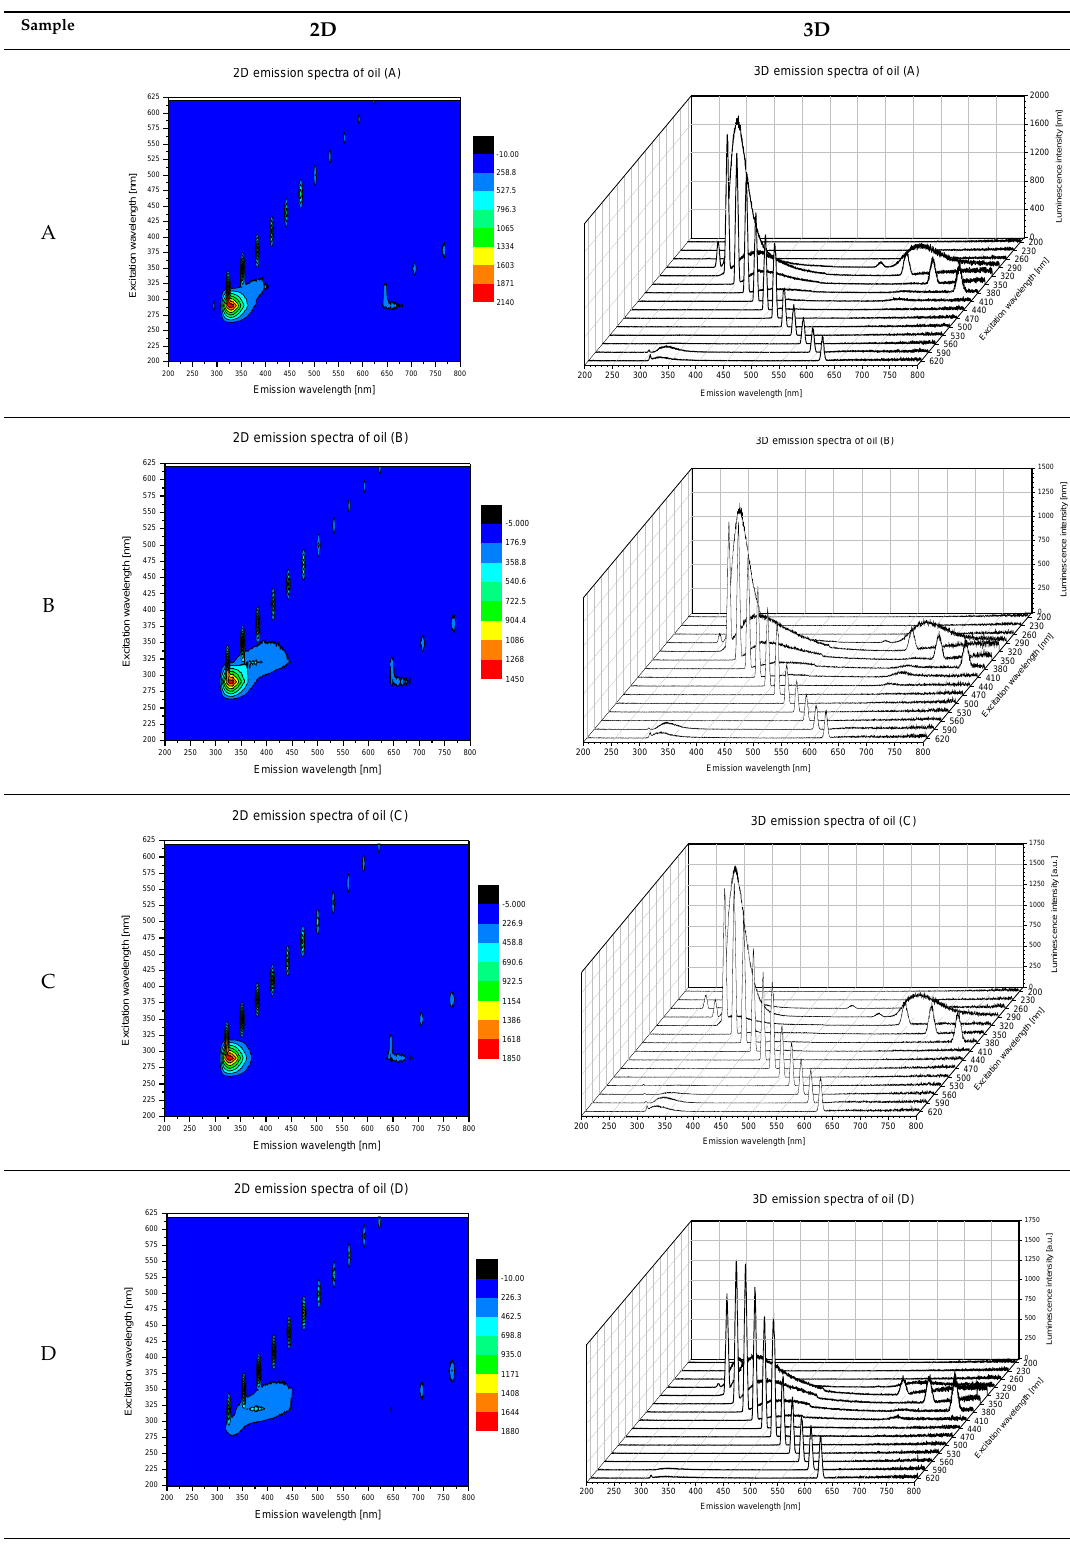
Table 1. 2D (left) and 3D (right) emission spectra of studied oils: (A) apricot ( Prunus armeniaca ) kernel oil; (B) blueberry oil; (C) argan ( Argania spinosa ) nut oil; (D) kiwi seed oil, (E) grape seed oil; (F) evening primrose ( Oenothera biennis ) oil; (G) Limnanthes alba (meadowfoam) seed